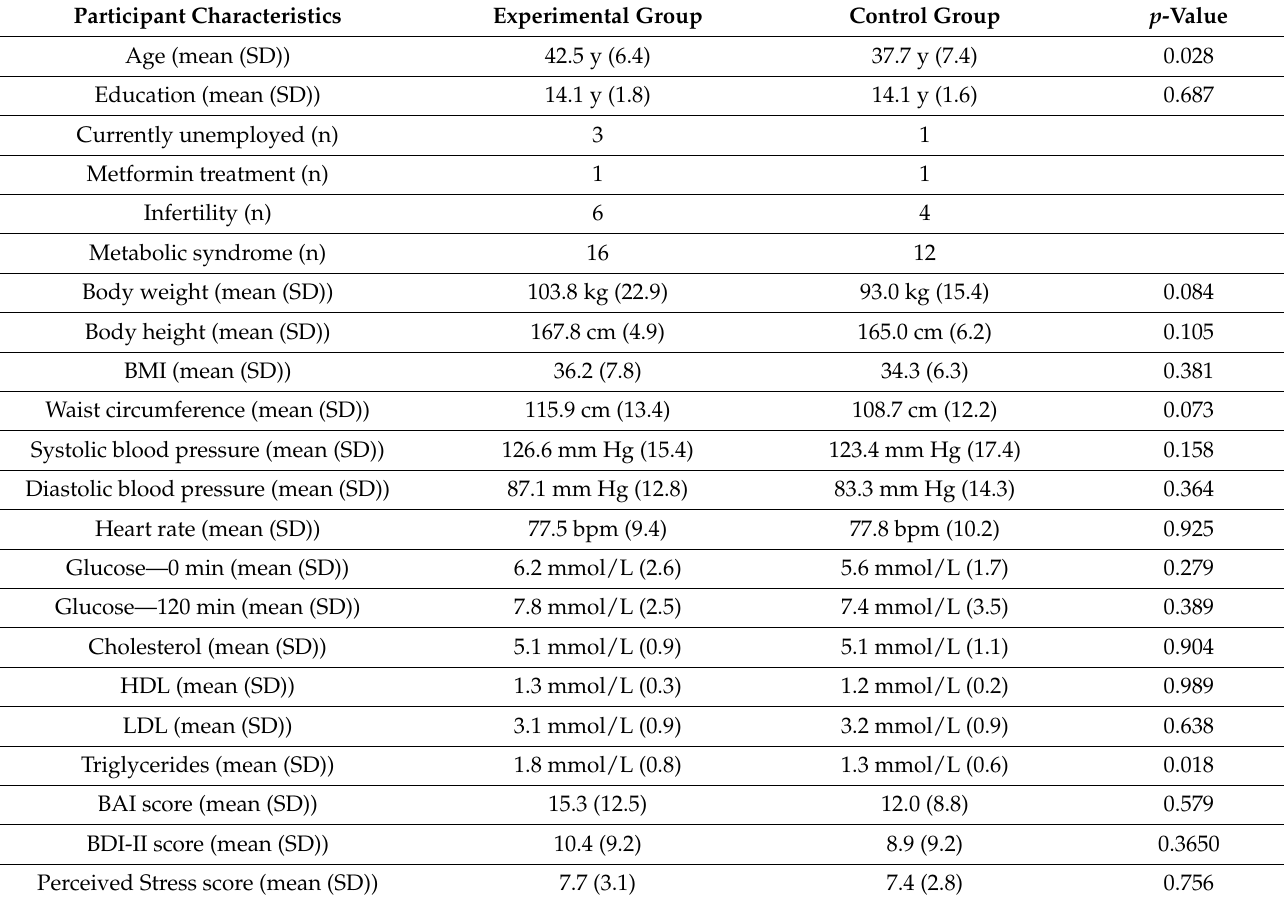
Table 1. Demographic, clinical, and laboratory characteristics of participants at baseline. Base- line characteristics were compared either using independent samples t -test or Mann–Whitney test as